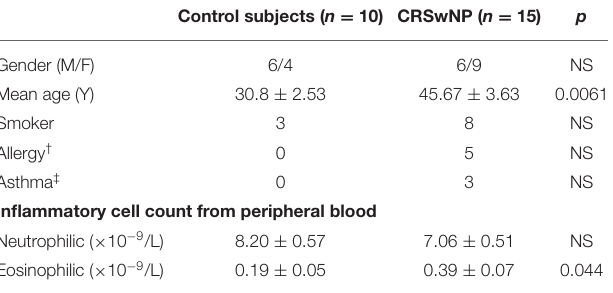
Supplementary Table 1 . Relative gene expression was calculated using the 2 − 11 CT